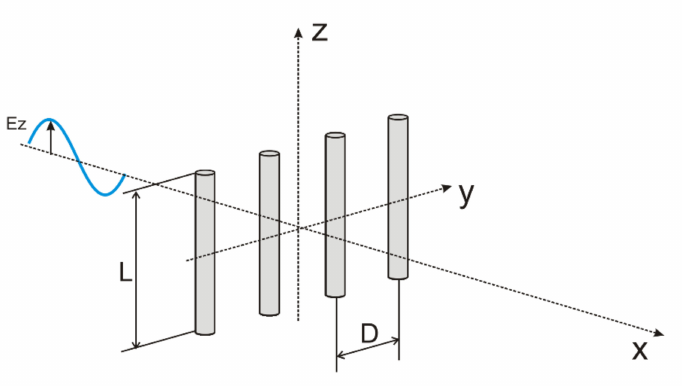
Figure 5. Geometry of four wire